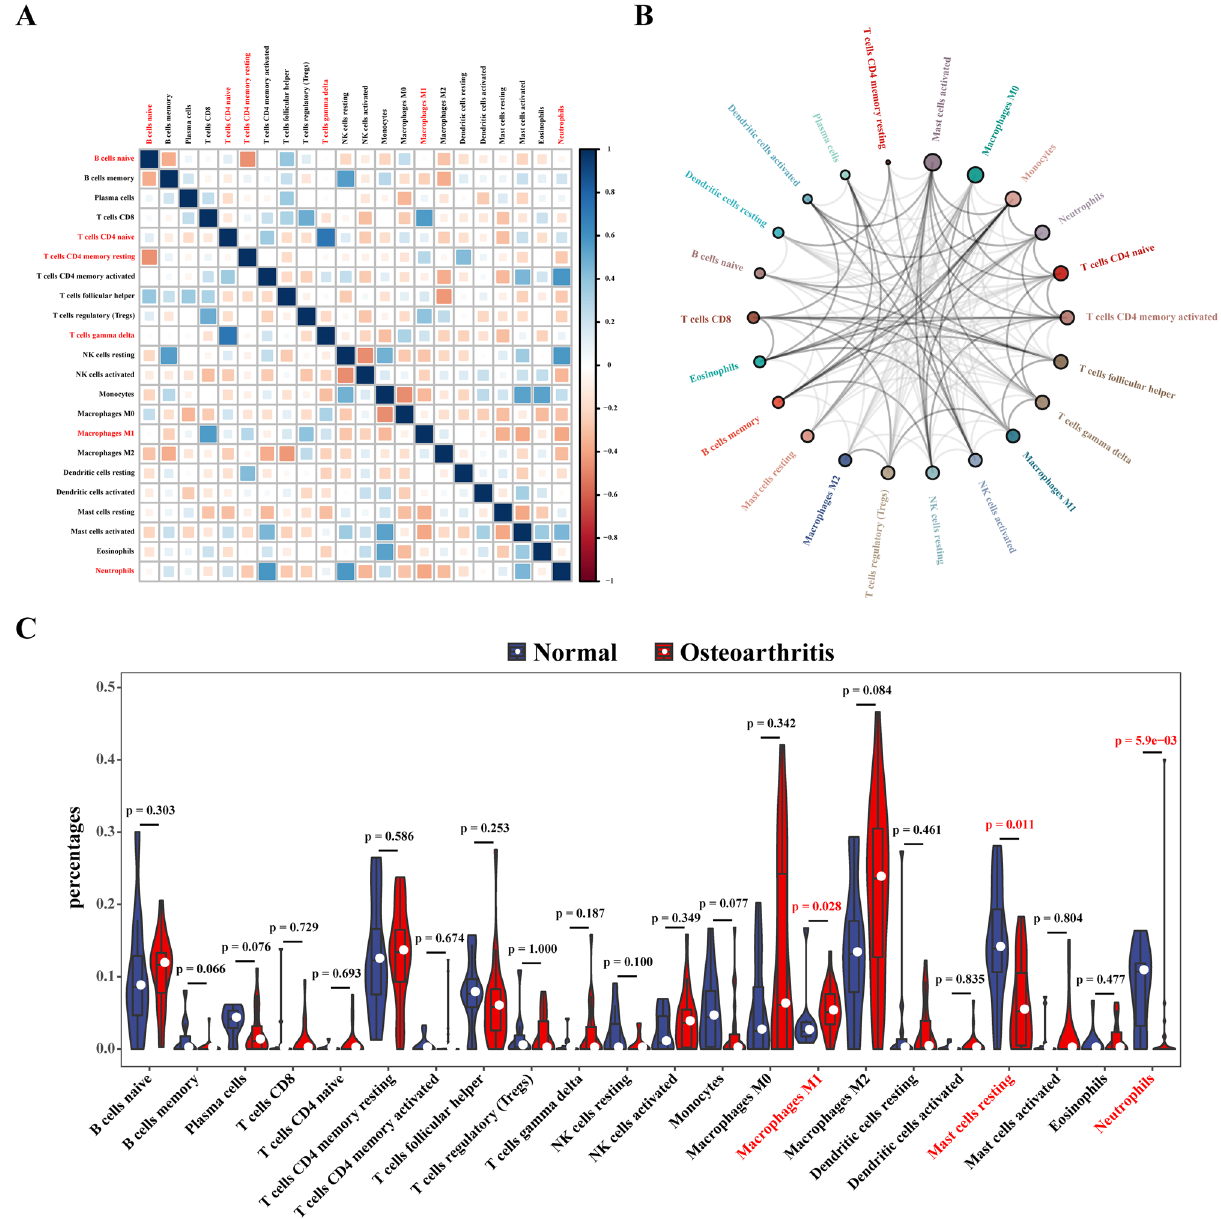
Figure 6. Correlation plots of immune cell infiltration analysis. ( A ) Correlation heat map of 22 immune cells. Blue represents positive correlation, red represents negative correlation, the darker the color, the stronger the correlation. ( B ) Network diagram of interactions of 22 types of immune cells. The size of the circle represents the interaction strength between immune cells infiltrating cells. ( C ) Violin plot of the proportion of infiltration by 22 types of immune cells in normal control samples versus in osteoarthritis samples. Red markers represent differences in infiltration between the two groups of